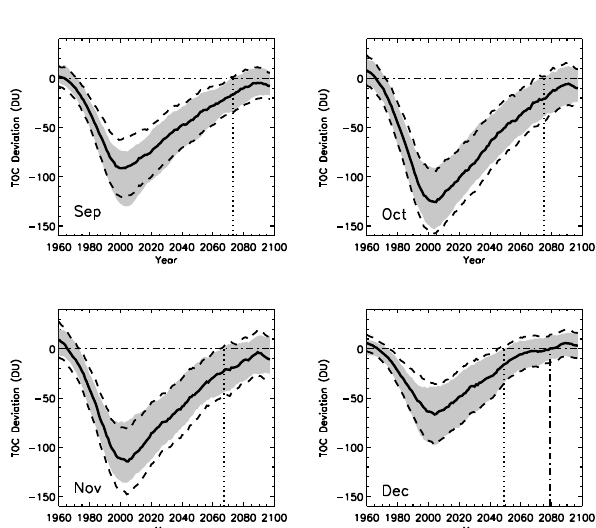
Figure 4. Time series of deviations for multi-model median TOC from the 1965 baseline for each month. Median TOC return dates are shown by the vertical dot-dashed lines. Shaded area is the 95% confidence limit of the median with the upper limits return dates shown by vertical dotted lines. Dashed curves show the median absolute deviation range.